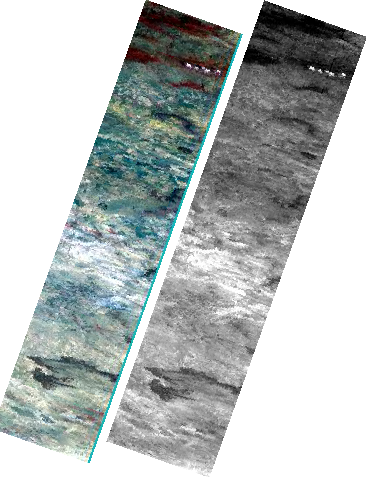
Figure 8. Cannabis negative detection in Algerian Hyperion data of